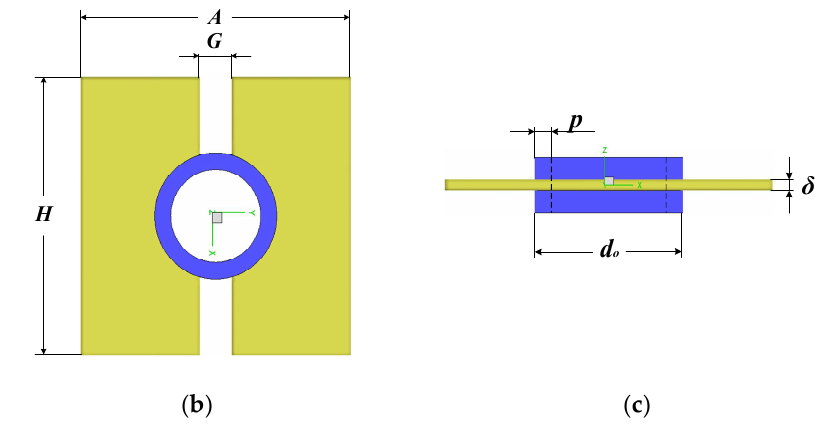
Figure 1. Schematic diagram of the H-type finned tube: ( a ) physical model; ( b ) top view of the H-type fin; ( c ) side view of the H-type fin. Table 1. Geometric parameters of the basic H-type finned tube in physical model. H /mm A